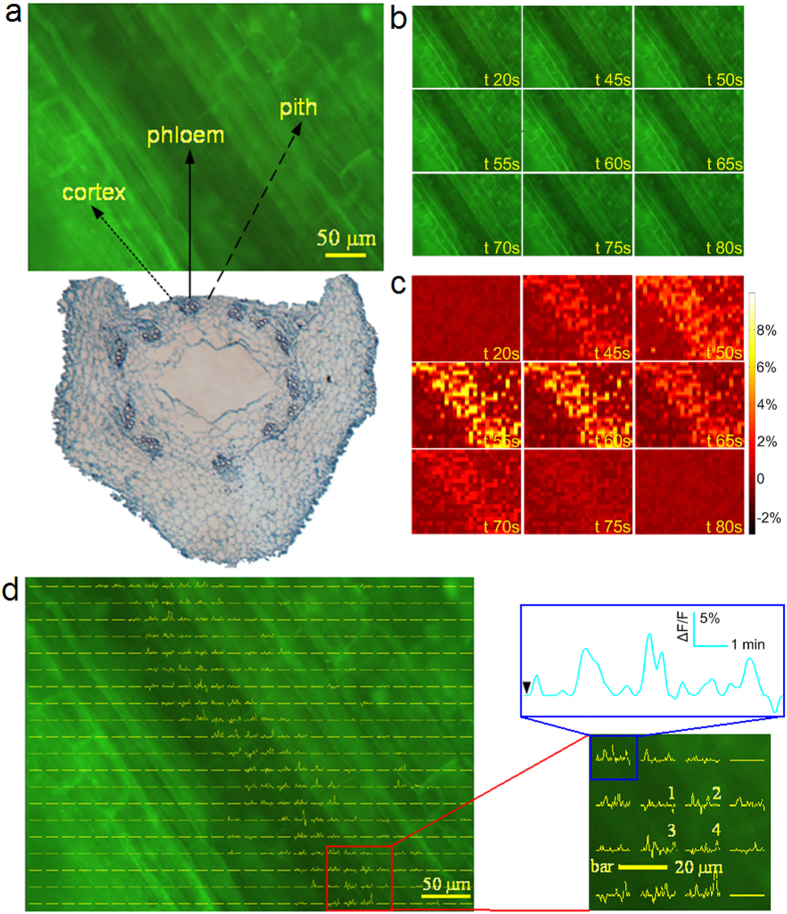
Typical optical recording of the distribution of the APs in the phloem region.(a) The different tissues such as the cortex, phloem and pith are shown in the radial face paraffin sections made at the end of the experiment. (b) A series of consecutive raw fluorescence images. (c) The time lapse ∆F/F images, where the variation of the fluorescence intensity can be clearly observed. (d) The results of the optical recording. The ΔF/F curves from the cortex, phloem and pith indicate that the ΔF/F change appears in the phloem region and that there was no obvious signal in the cortex and pith regions. The maximum amplitude of the ΔF/F signal is shown in the blue rectangle, which was magnified by approximately 8%. In the adjacent regions numbered 1, 2, 3, and 4 with center distances of about 20 μm, the maximum amplitude of the ΔF/F signal was about 5%, 7%, 10% and 4%, respectively.